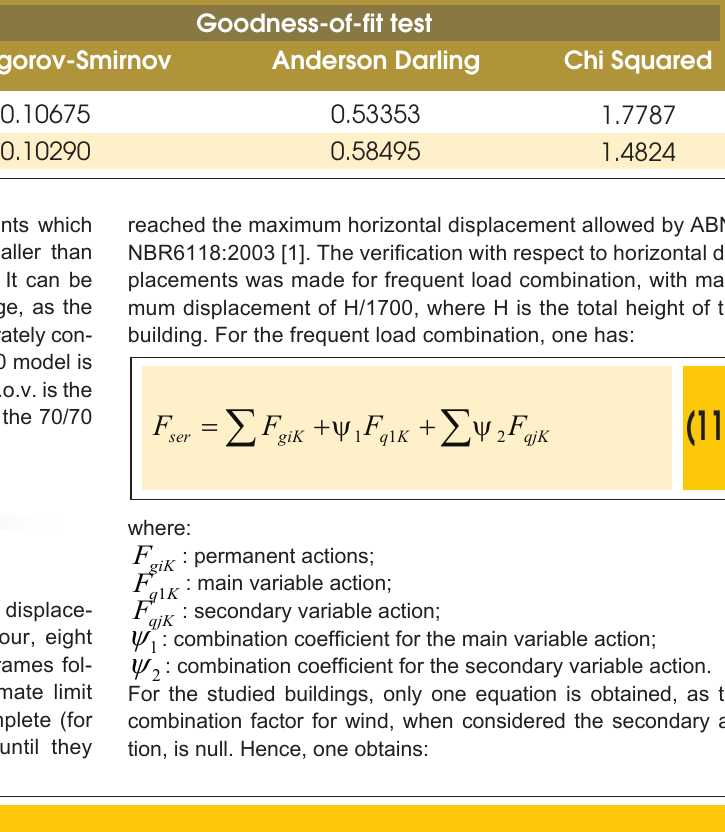
Table 3 – Characteristic and nominal resistance and load values considered in design